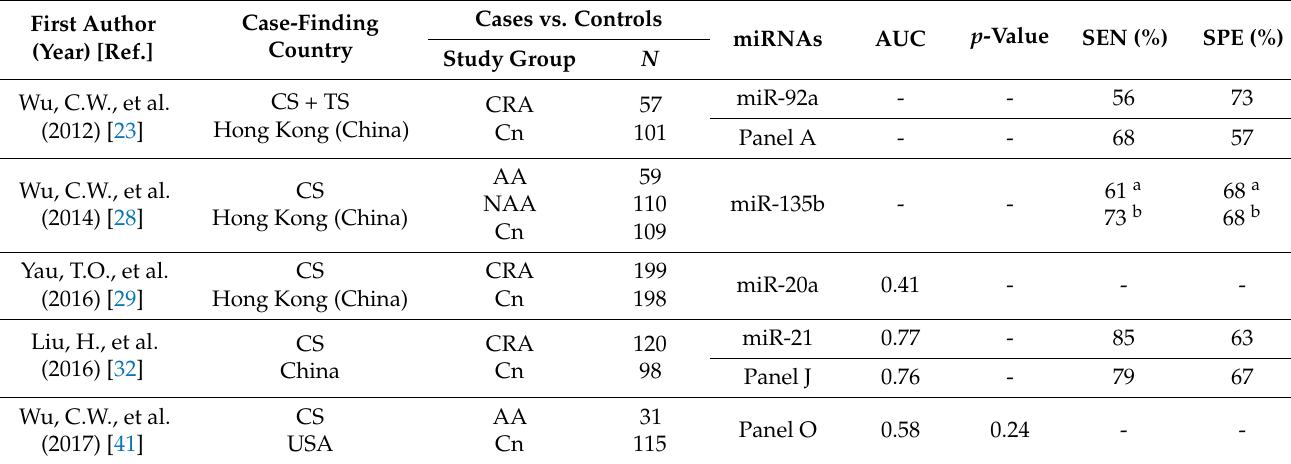
algorithm: fecal level of miR-421, miR-27a-3p, hemoglobin, and patient age and sex) identifying patients with CRC, compared to fecal hemoglobin concentration alone with an AUC of 0.67 (100% sensitivity, 31% specificity). The team further delineated four risk categories for all participants using miRFec algorithm scores [44] and found that the